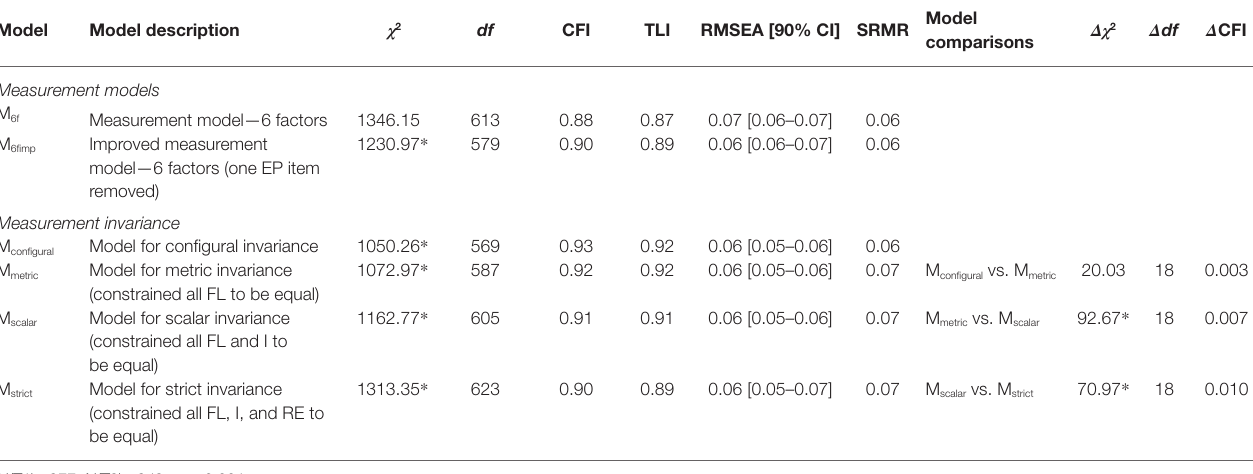
TABLE 2 | Fit statistics for the measurement models and measurement invariance. Model